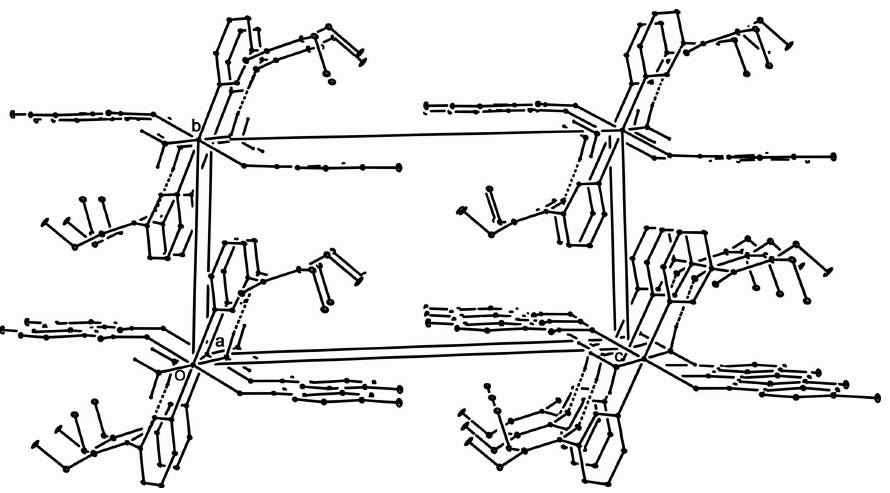
Figure 2 A packing diagram of the title compound, viewed down the a -axis, showing hydrogen bonds (dashed lines) linking the molecules into chains. H atoms not involved in hydrogen bonds have been omitted for